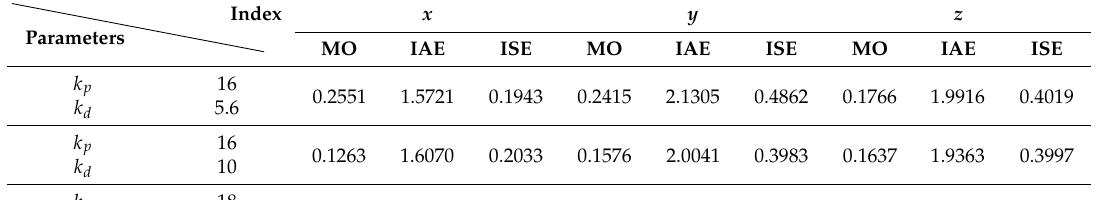
Table 6. Comparison of experiment results under three sets of PD parameters.